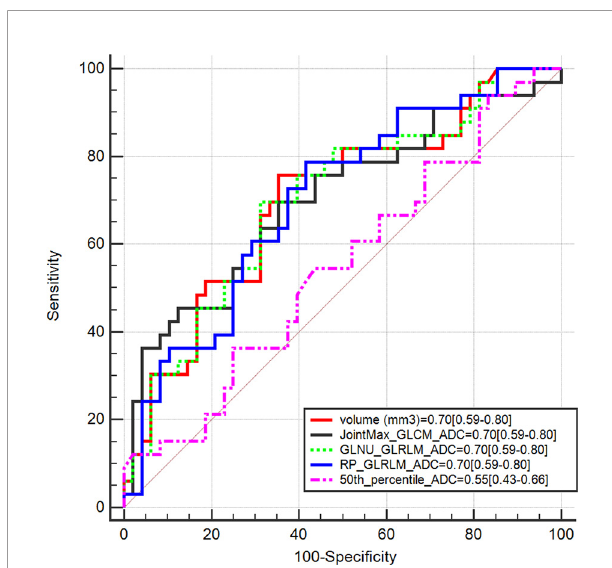
FIGURE 3 | Area under the receiver operating characteristic curve (AUC) of radiomics features having AUC ≥ 0.7 compared with AUC of the 50th percentile of apparent diffusion coef fi cient (ADC).